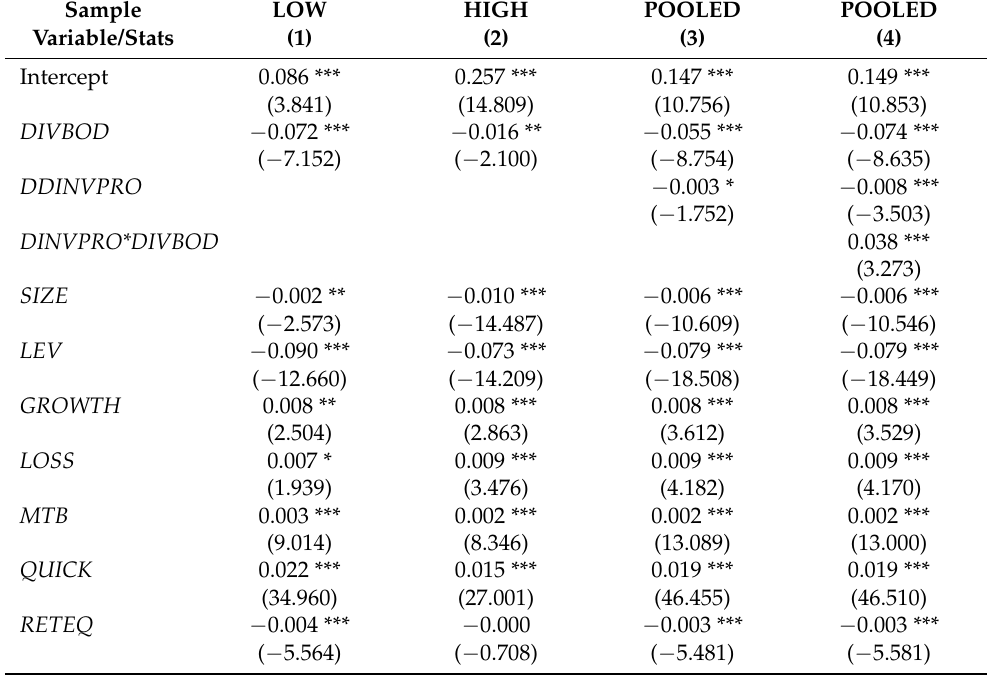
Table 2. Regression estimates of the effect of investor protection and board diversity on corporate cash